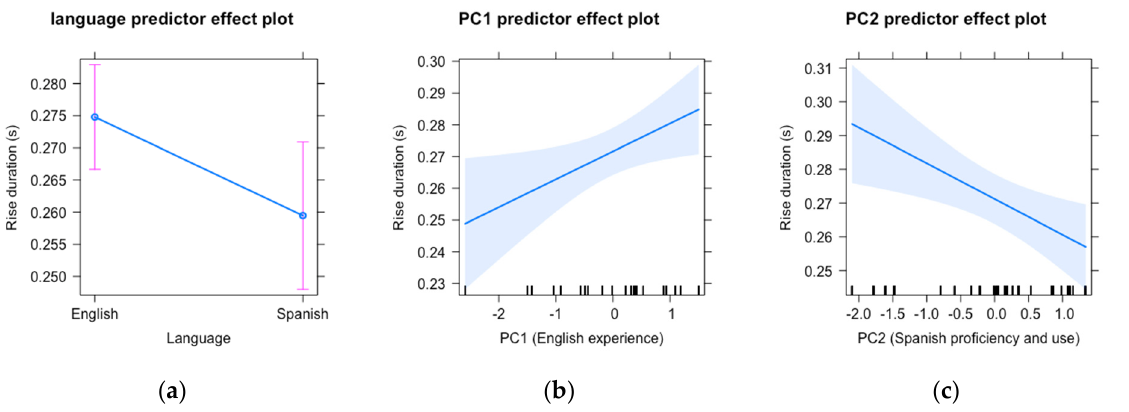
Figure 3. Rise duration (s) by ( a ) language; ( b ) English experience (PC1); ( c ) Spanish proficiency and use (PC2).